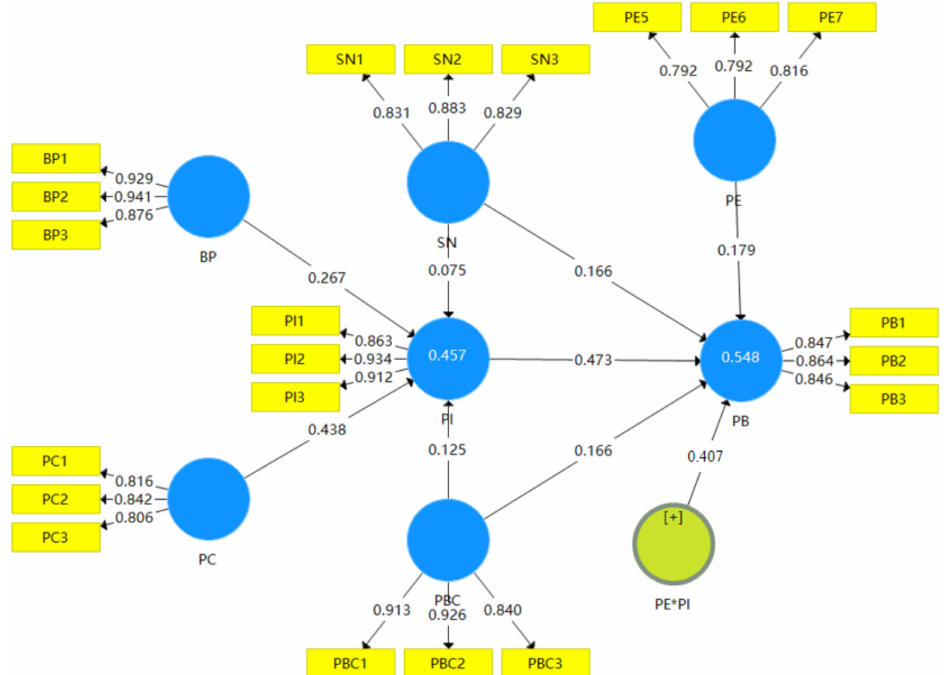
Figure 2. Path diagram of modified